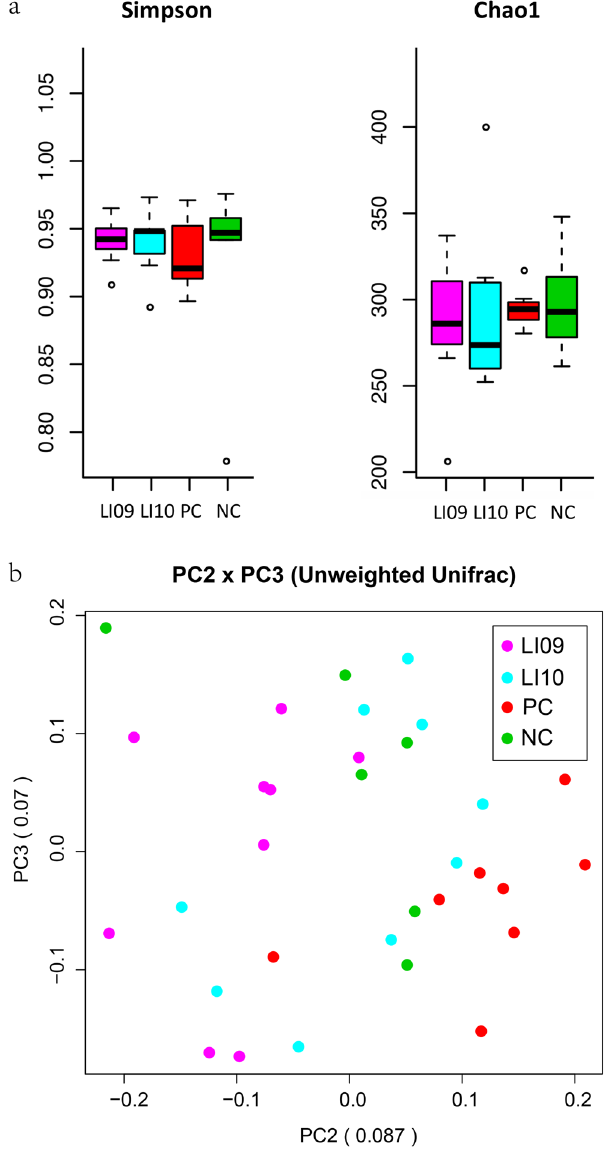
Figure 4. Effects of pretreatment with B. pseudocatenulatum LI09 or B. catenulatum LI10 on the overall structural changes of gut microbial communities during D-GalN-induced acute liver injury. ( a ) The alpha diversity of the gut microbiome, determined by Simpson index and Chao1 index, in the LI09 or LI10 group was compared with that in the PC group. Values are expressed as the median with interquartile range. ( b ) The principal coordinate analysis (PCoA) plot shows the beta diversity of the gut microbiome with unweighted UniFrac distance derived from 16S-based sequencing data. Composition profiles of the caecal flora in the LI09 or LI10 group was compared with those in the PC and negative acute liver injury control (NC)